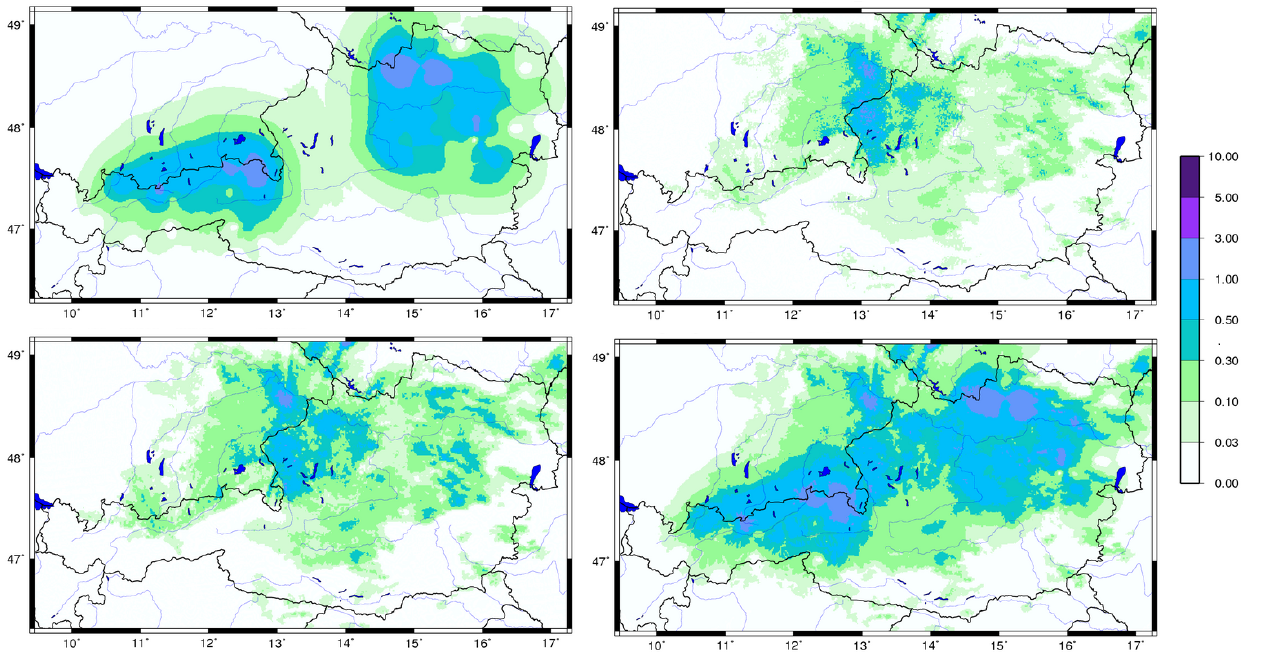
Figure 1. Example of a 15-min INCA precipitation analysis (23 Jun 2009, 00:15–00:30Z) during a flooding event in Central Europe. Upper left panel: pure station interpolation, upper right panel: uncorrected radar field, bottom left panel: corrected radar field, bottom right panel: final INCA precipitation analysis. Units are mm, with color scale on the